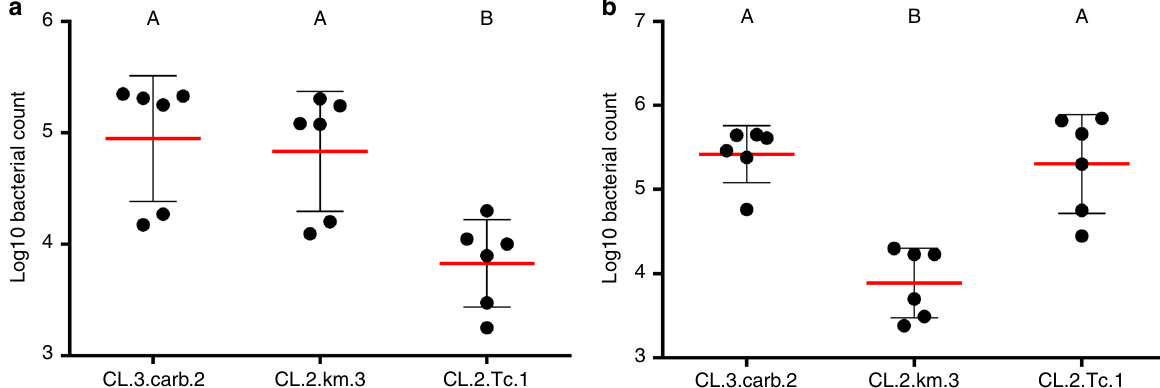
Fig. 7 Strain abundance in mosquitoes colonized by simpli fi ed microbial communities. Each point indicates the colony forming units (cfu) of each of three strains that were introduced to individual a axenic larvae or b axenic adults. The red horizontal bar represents the mean with error bars indicating the standard error of the mean. Counts were determined from 6 individuals for both the larvae and adults. Columns labeled with different letters were signi fi cantly different as determined by a one-way analysis of variance with a P -value cutoff of